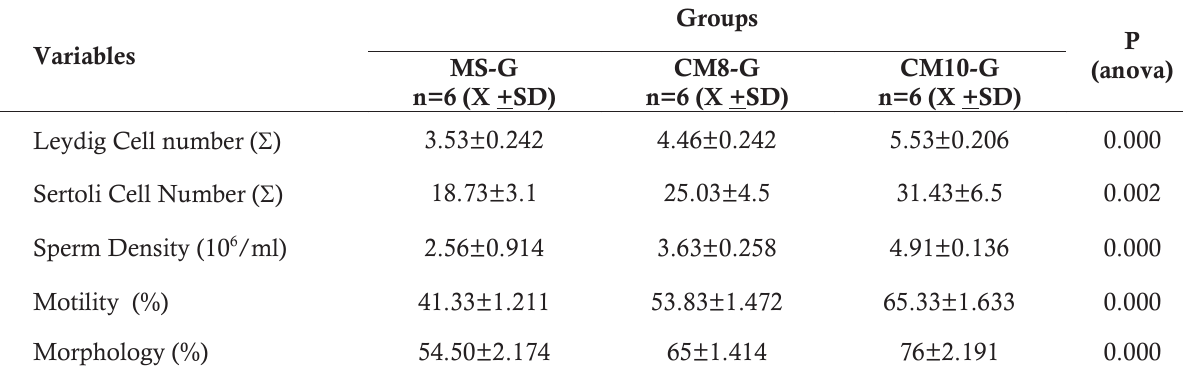
Table 1. Average leydig cells count, sertoli cells count and spermatozoa count, motility and morphology.